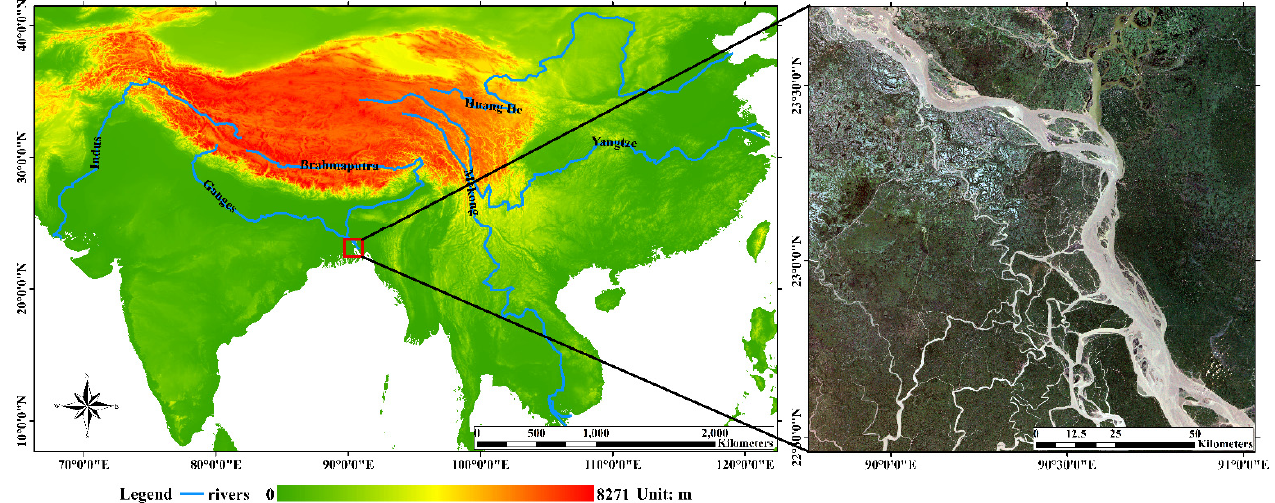
Figure 1. Illustration of the location of the study area. The image on the left-hand side shows a map of the East Asian continent with digital elevation model (DEM) data downloaded from USGS as the background. The blue lines signify six large rivers originating from the Tibetan Plateau. The area within the black outline is the Ganges–Brahmaputra River Basin, while the area within the red box is the study area. The image on the right-hand side is an example of a Landsat 5 TM image of the Padma River (taken on 17 October 1994).